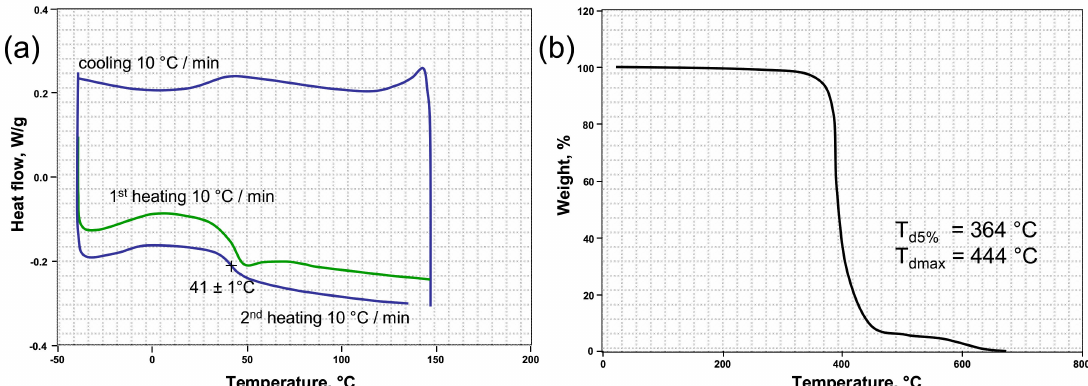
Figure 2. Differential scanning calorimetry (DSC) ( a ) and thermogravimetric analysis (TGA) ( b ) curves of the crosslinked PETMP-TTT polymer network.